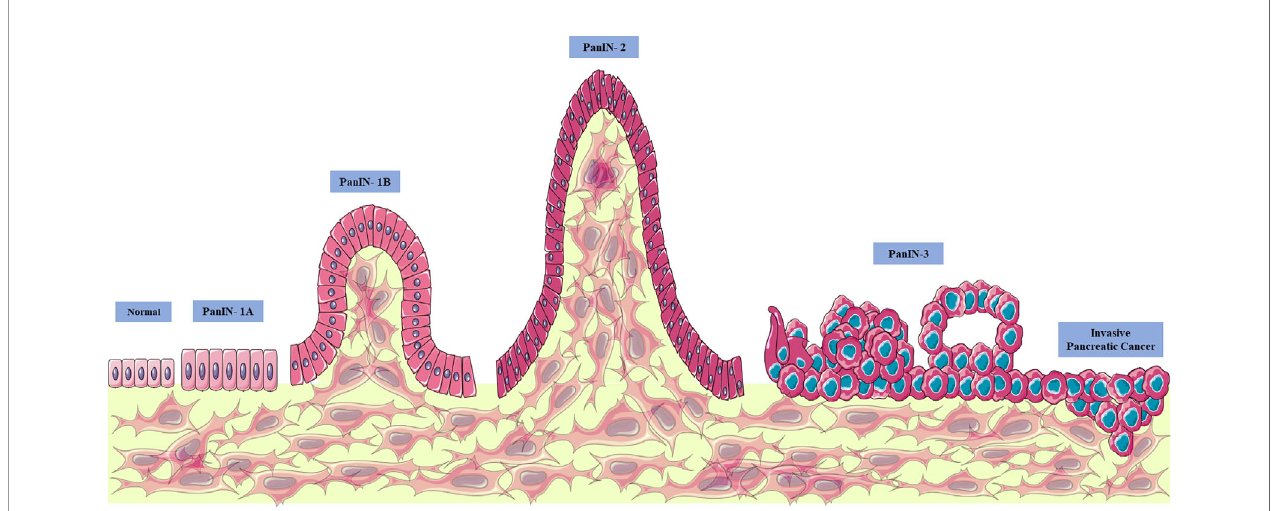
FIGURE 1 | Evolution of pancreatic cancer. Pancreatic cancer appears through proliferative lesions PanINs (located in the pancreatic ducts), evolving to PanIN-1 (low grade lesions with in fi ltration of the carcinoma and accumulation of genetic alterations and in fi ltration), intermediate lesions with progression histological, hyperplasia, and primary carcinoma) and PanIN3 (high grade lesions with metastasis, called “ carcinoma in situ ” ) and fi nally pancreatic ductal adenocarcinoma (the most prevalent and lethal form of this type of neoplasia). From: Author. This fi gure used elements from Servier Medical